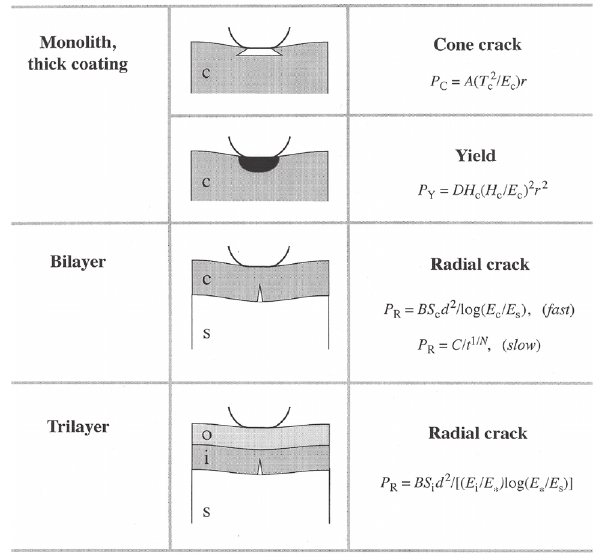
FIGURE 3 - Schematic of ceramic layers c (bilayers), o and i (trilayers) on compliant substrates s. Common damage modes from occlusal-like contacts indicated: surface cone cracks and quasiplastic yield zone at top surface; flexural radial cracks at ceramic bottom surfaces. Corresponding analytical relations for critical loads given, in terms of key variables: contact test —load P , test duration t ; geometric — layer thickness d , sphere radius r : materials , Young’s modulus E , hardness H , strength S , toughness T , crack velocity exponent N . Quantities A , B , C and D are coefficients